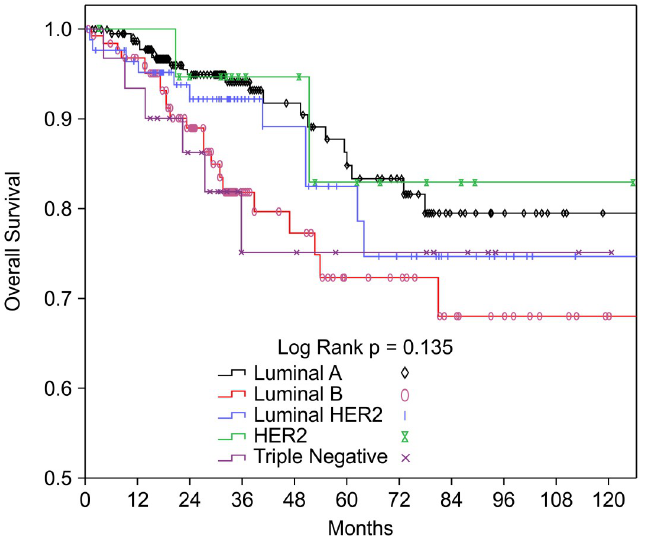
Fig 2. Kaplan–Meier curves of overall survival according to lymph node status and breast cancer subtype. HER2, human epidermal growth factor receptor 2.